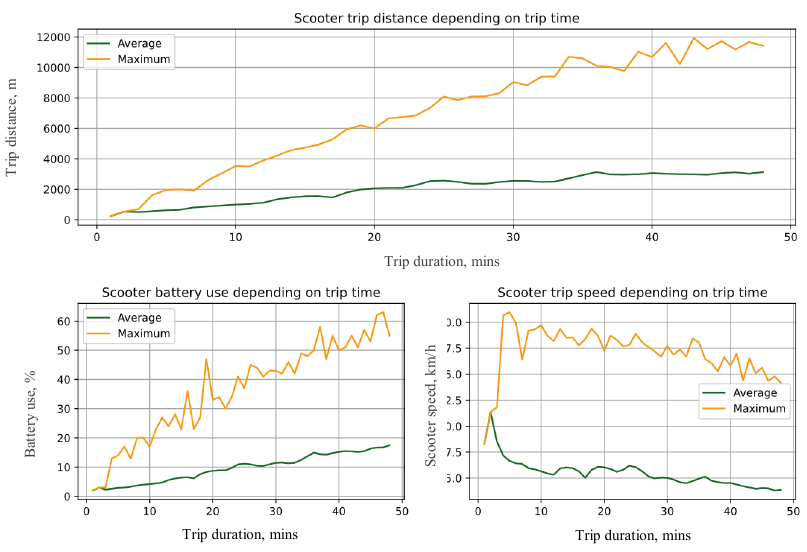
Fig. 5. Maximum and average trip data depending on the trip